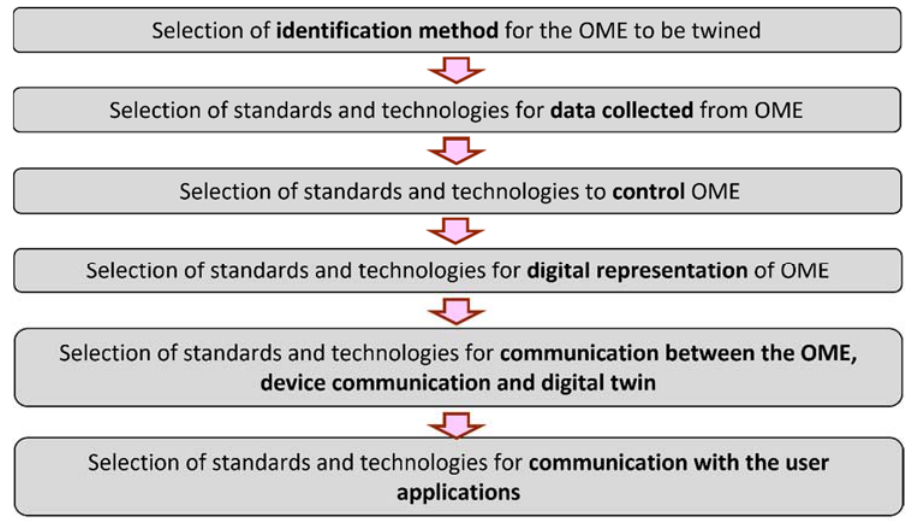
Figure 2. Observable Manufacturing Elements (OMEs) [6] . MFG = manufacturing.